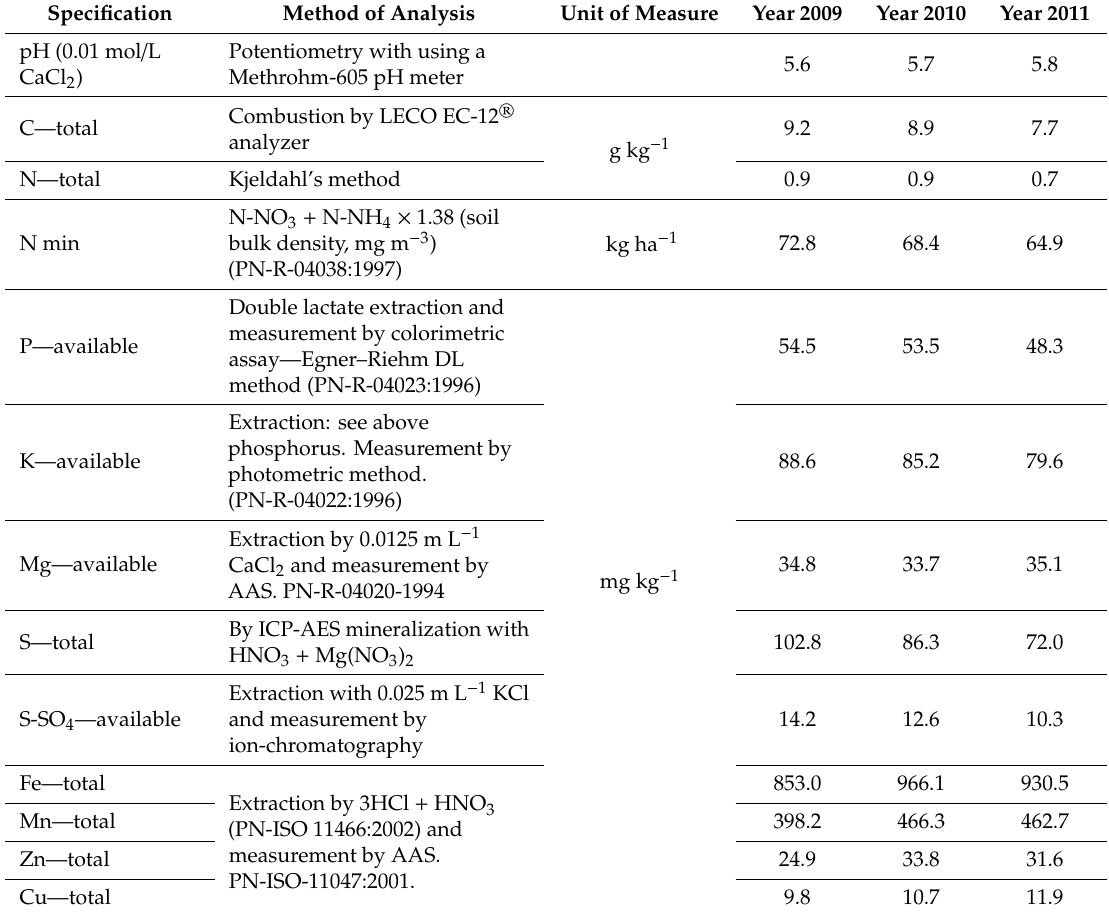
Table 1. Chemical characteristics of the soil layer of 0–20 cm (before sowing).